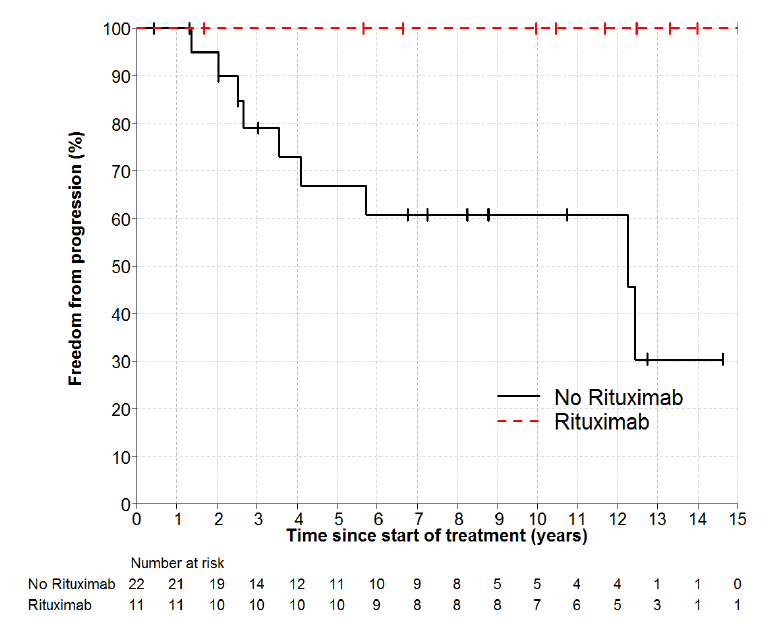
Figure 5. Freedom from Progression by Rituximab p = 0.025*. * HR not estimable, no rituximab patient